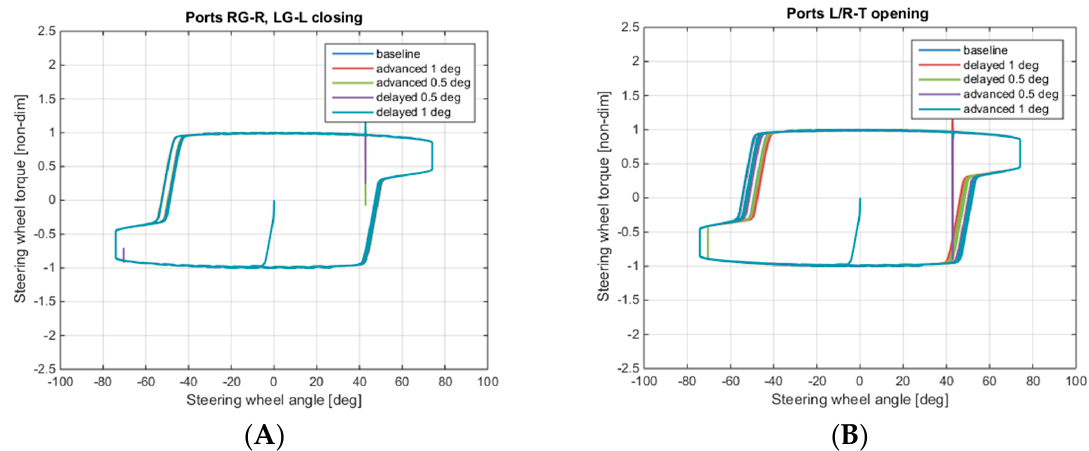
Figure 17. ( A ) Steering wheel torque-angle curve obtained translating the flow areas RG-R and LG-L; ( B ) Steering wheel torque-angle curve obtained translating the flow areas R-T and L-T.